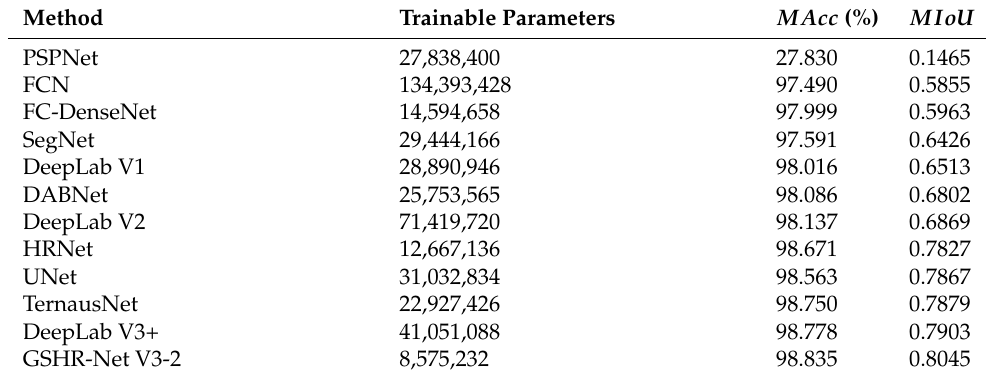
Table 2. Apple recognition performance comparison between the proposed method and state-of-the- art